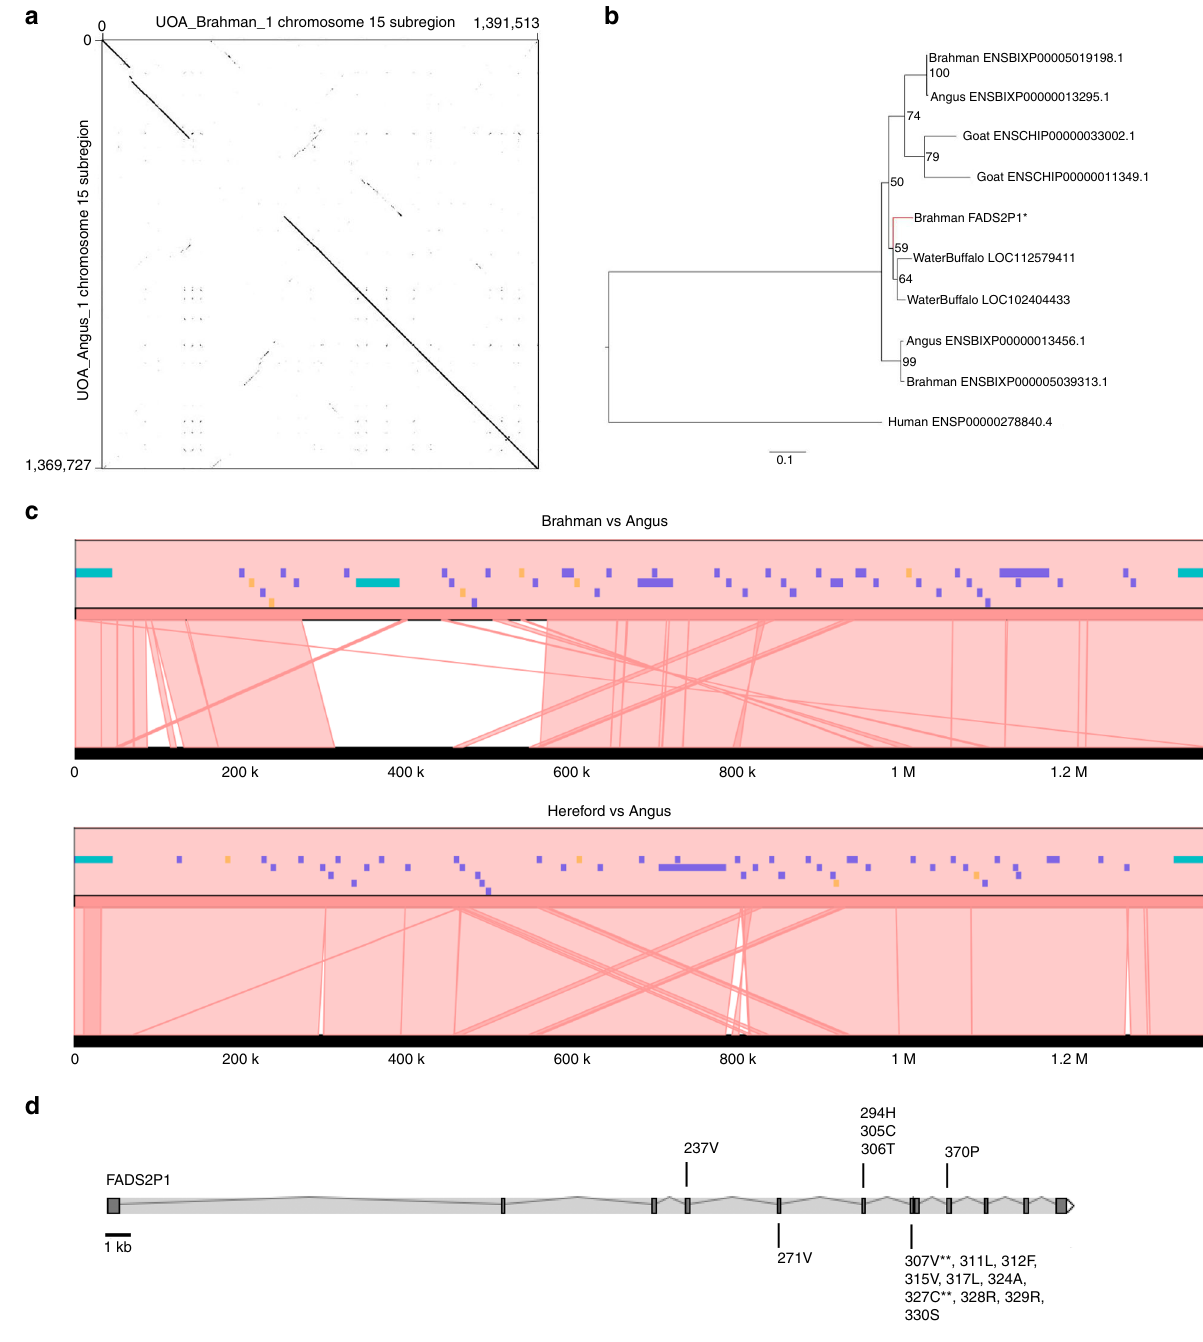
Fig. 3 Divergence of the FADS2P1 locus between indicine and taurine cattle. a Dot plot of Brahman chromosome 15 between positions 3,748,952 to 5,140,465 against the homologous Angus chromosome between positions 78,799,177 to 80,168,904. The Brahman sequence was reverse complemented in the plot. b Maximum likelihood tree with 1000 bootstraps of FADS2P1 homologous protein sequences. The extra Brahman FADS2P1 copy is highlighted with asterisk (*) and its branch colored red. c Microsynteny plot showing a lack of sequence conservation between indicine and taurine breeds around the indicine-speci fi c FADS2P1 gene. All FADS2P1 genes are colored turquoise, other genes purple, and pseudogenes orange. The upper plot compares Brahman to Angus and the lower plot compares Hereford to Angus. The track in black in both panels is the Angus reference. The Brahman FADS2P1 gene Ensembl IDs are ENSBIXG00005007613, ENSBIXG00005021668, and ENSBIXG00005022680, whereas the Angus IDs are ENSBIXG00000018262 and ENSBIXG00000018381. The indicus-speci fi c copy of FADS2P1 is ENSBIXG00005007613. d Mapping of 16 positively selected sites onto the exons of Brahman FADS2P1 . The residues with double asterisks (**) indicate they have Prob ω > 1 ð Þ > 0 : 99 (i.e., highly signi fi cant positively selected